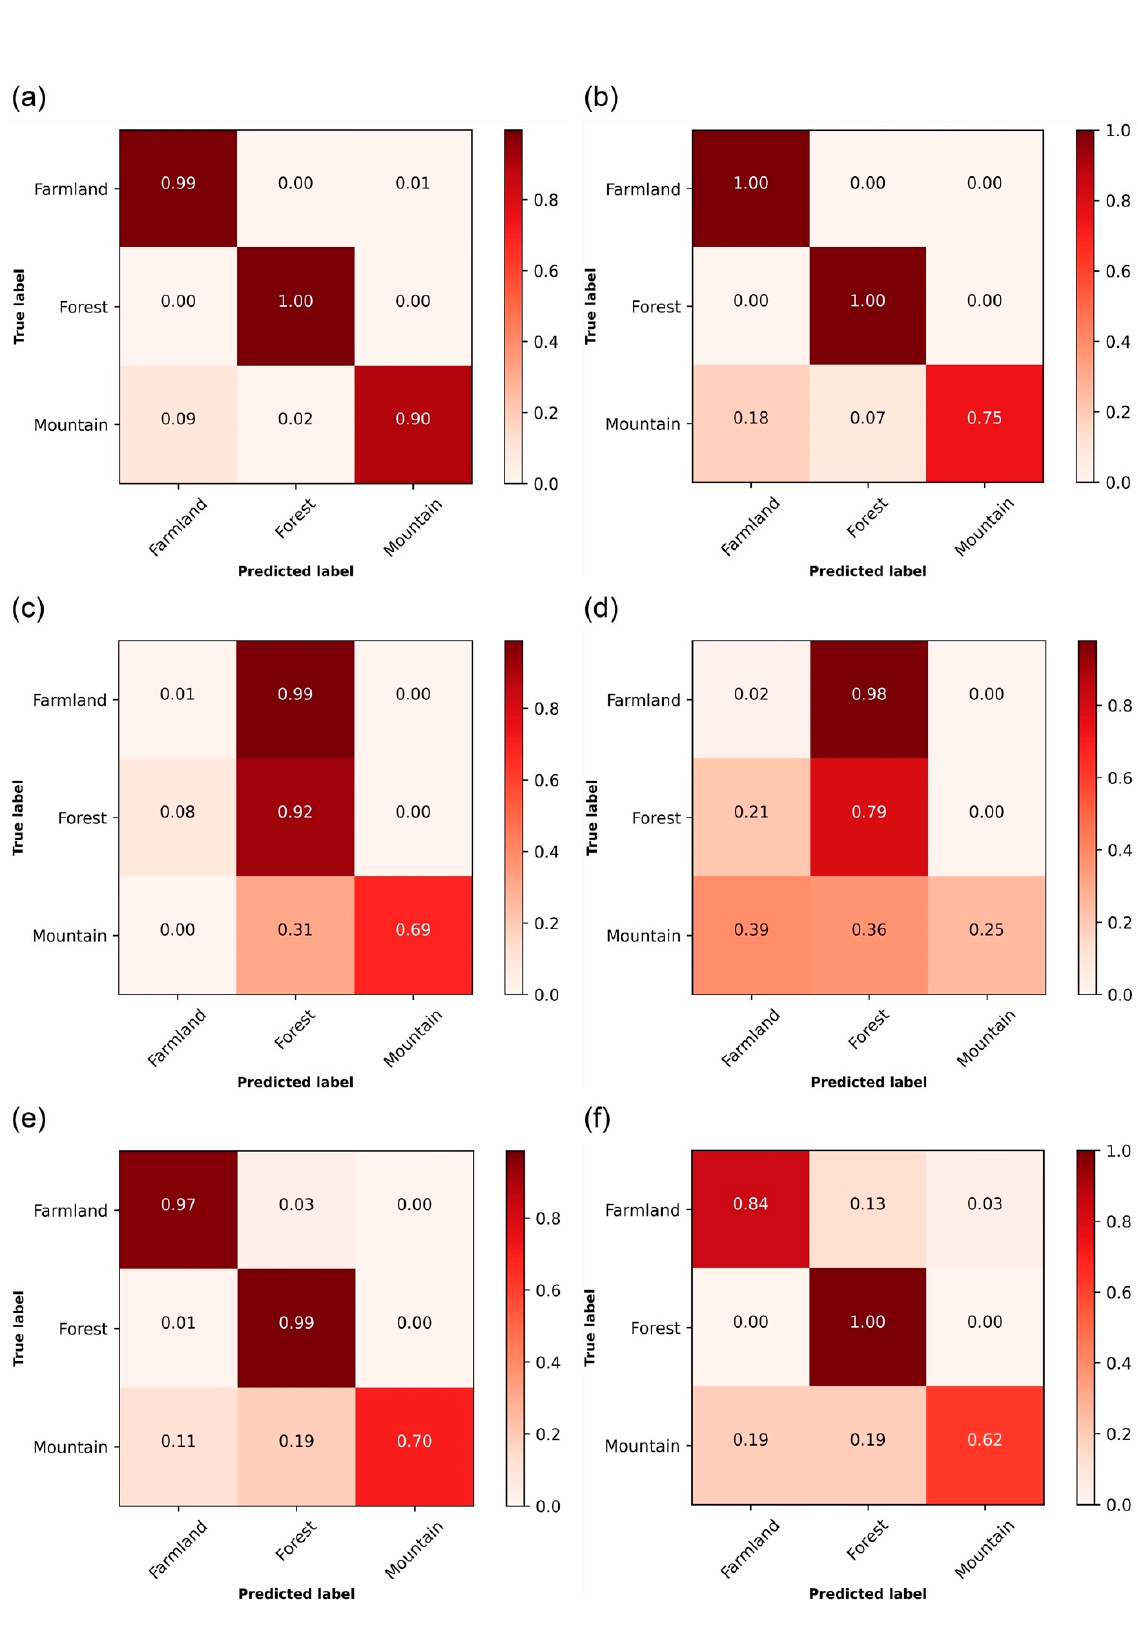
Figure 6. Confusion matrix for landscape-type classification accuracy. ( a , b ) Tex-CNN and classical CNN accuracy on AID. ( c , d ) Classification accuracy for Tex-CNN and classical CNN on Sentinel dataset. ( e , f ) Fine-tuned accuracy for Tex-CNN and classical CNN, respectively, on a combination of AID and Sentinel test data.